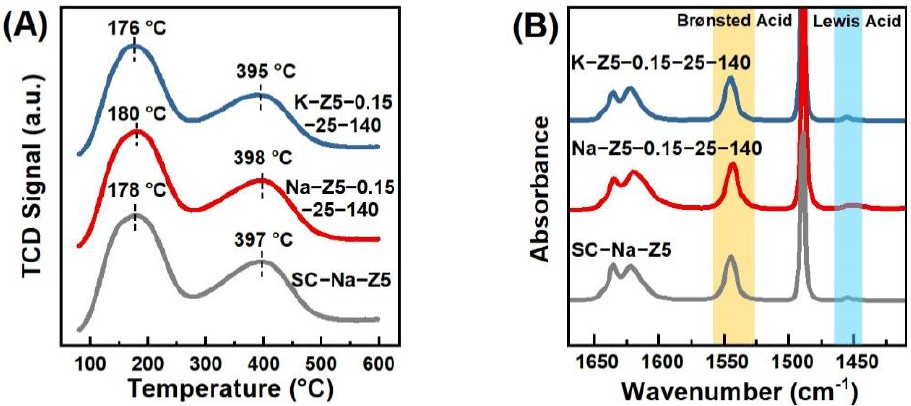
Figure 5. ( A ) NH 3 -TPD profiles and ( B ) FT-IR spectra with pyridine adsorption for three typical ZSM-5 zeolite samples.